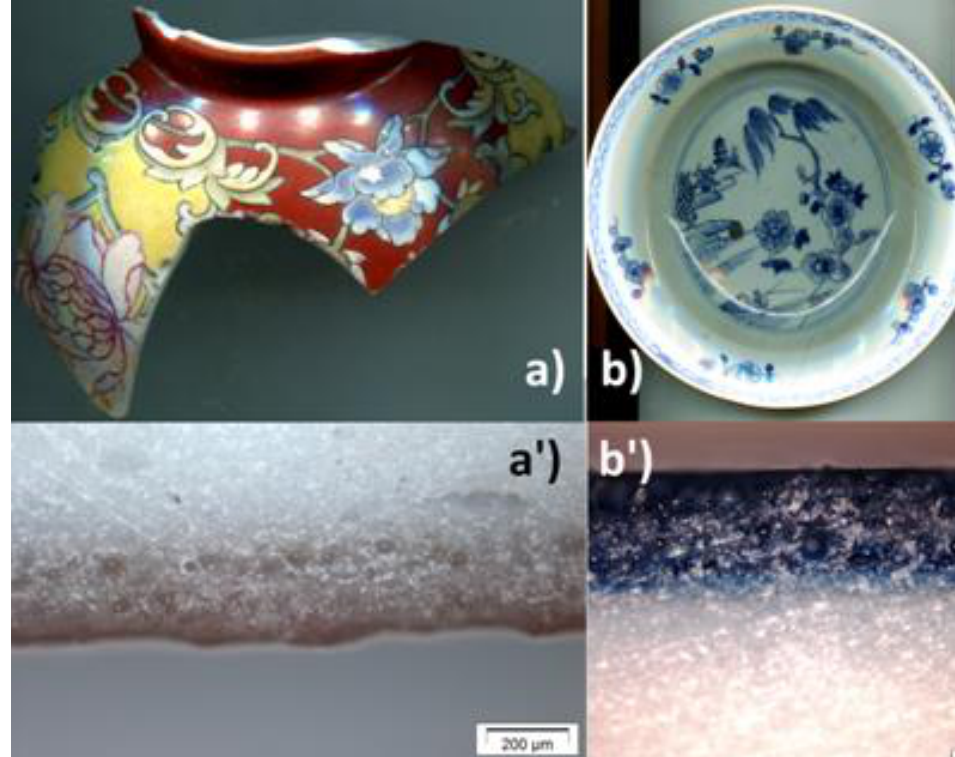
Figure 1. Fragment of an imperial porcelain bowl (QL) with falangcai enamels ( a ) and corresponding cross-section ( a’ ), and the dish with blue and white underglaze decoration (ww) ( b ) and its cross-section ( b’ ), both objects being from the Qianlong reign period.